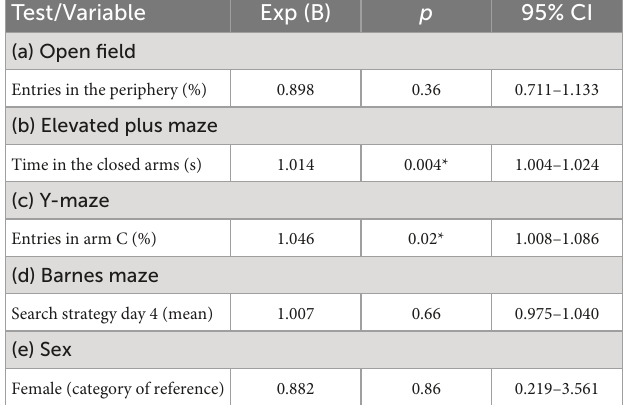
TABLE 2 Quantitative regression model to test the relationship between variables of interest with the extreme behaviors in the ladder walking test. Test/Variable